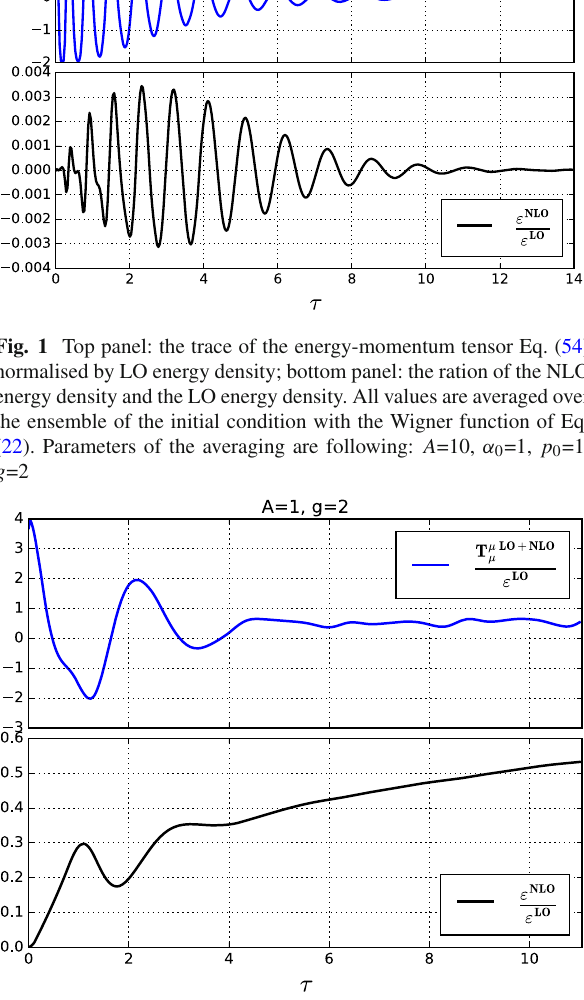
Fig. 2 The same as for Fig. 1 but with A =1